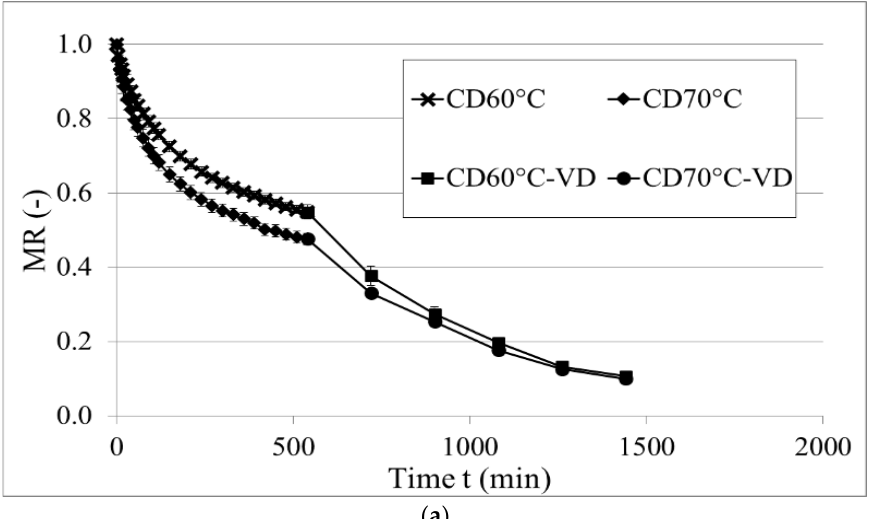
Figure 1. Fresh black garlic sample ( a ), black garlic after drying ( b ), and black garlic powder ( c